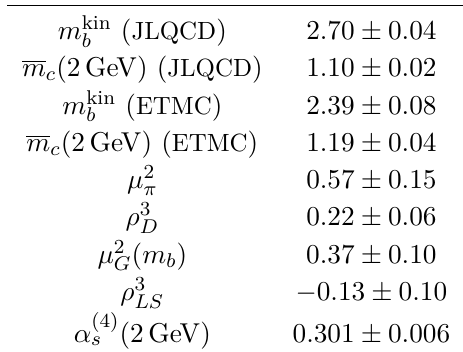
Table 1 . Inputs for our OPE calculation. All parameters are in GeV to the appropriate power and all, except m c , in the kinetic scheme at µ = 1 GeV. The heavy-quark masses for the ETMC setup are 100% correlated. As a remnant of the semileptonic fit, we include a 50% correlation between µ 2